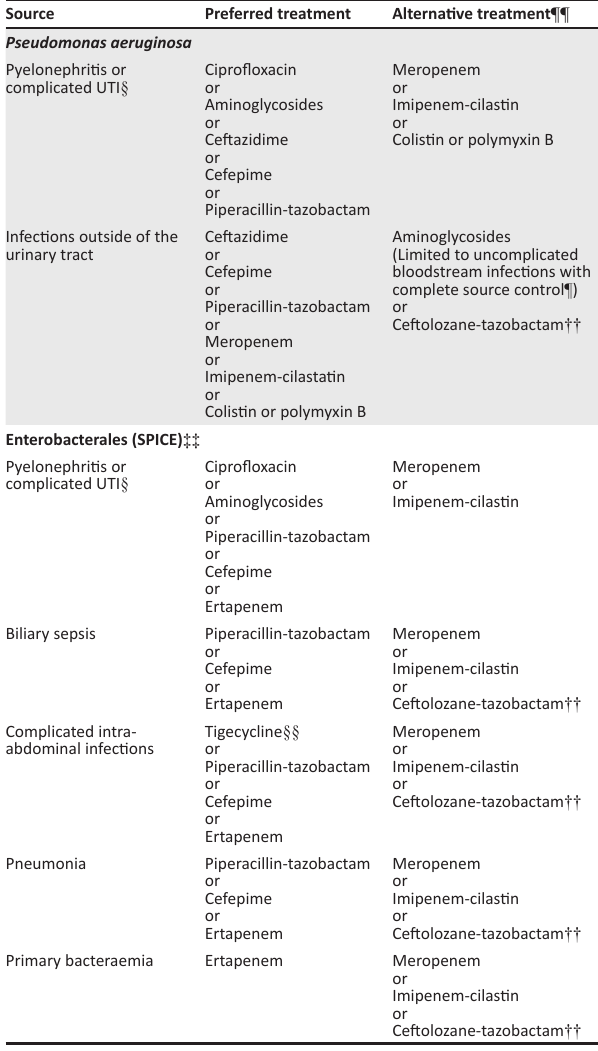
TABLE 3: Recommended intravenous antibiotic treatment options for AmpC producing bacteria. † , ‡